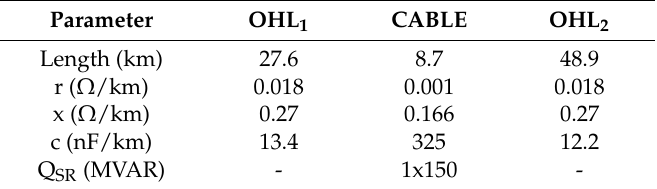
Table A10. Parameters of mixed overhead-cable transmission line—old link (single circuit).